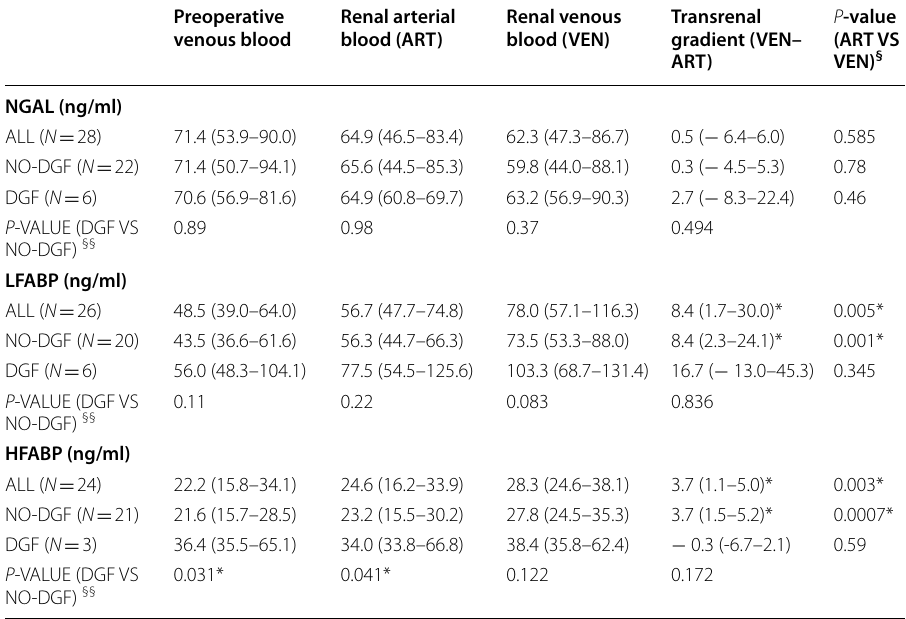
Table 3 Concentrations of NGAL, LFABP and